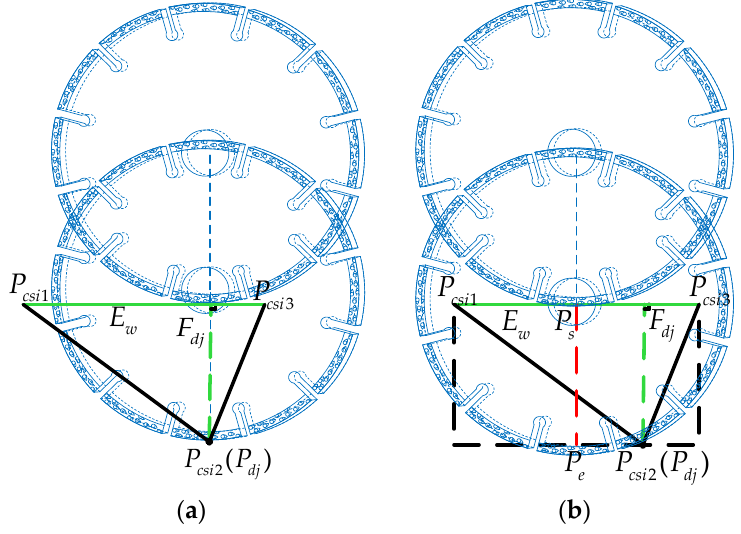
→ P P . Figure 10. Feed direction of cutting. ( a ) Feed direction along W ; ( b ) feed direction along P s P e s e P P . s e